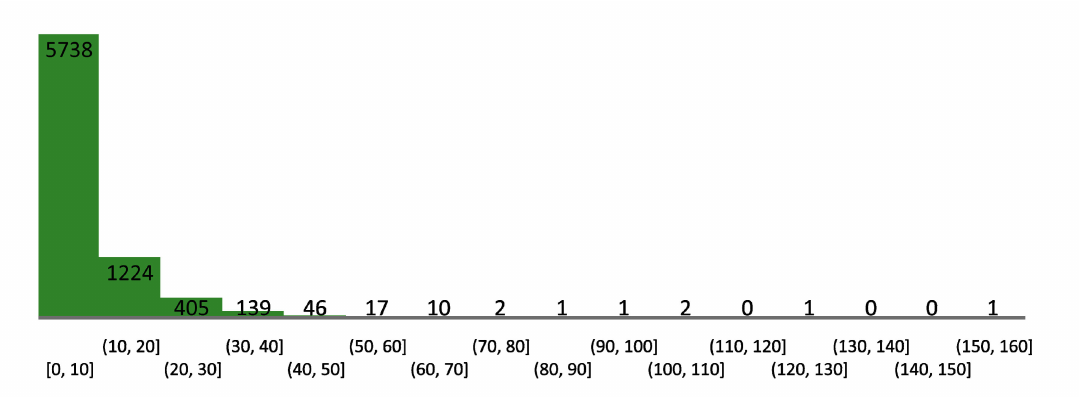
Figure 27. Authors’ H-index histogram. Table 1. Top 20 of the authors with the highest H-index published in journal